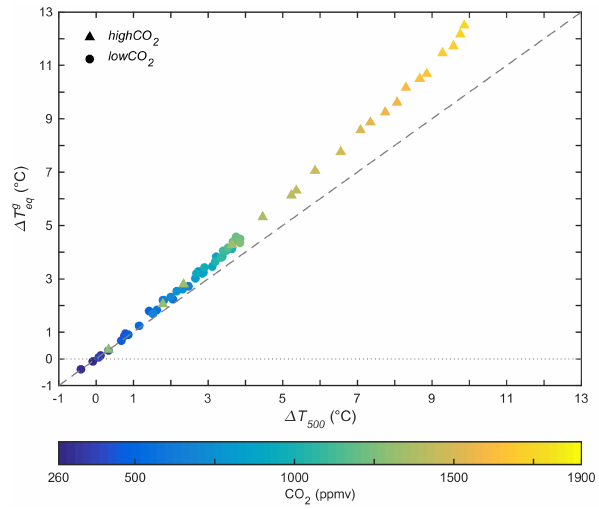
Figure 7. Equilibrated global mean annual change in SAT ( (cid:49)T eq , g ◦ C, blue), estimated by applying the (cid:49)T g eq , eq /(cid:49)T 500 ratio identified using the Gregory methodology to the GCM data, against atmo- spheric CO 2 (ppmv) for the low CO 2 (circles) and high CO 2 (trian- gles) modice ensembles. Also shown is (cid:49)T 500 (green), along with the idealised relationship between ln(CO 2 ) and (cid:49)T (red lines) for a climate sensitivity of 3 ◦ C (solid), 1.5 ◦ C (lower dashed) and 4.5 ◦ C (upper dashed) (IPCC, 2013). SAT is shown as an anomaly com- pared with the pre-industrial control